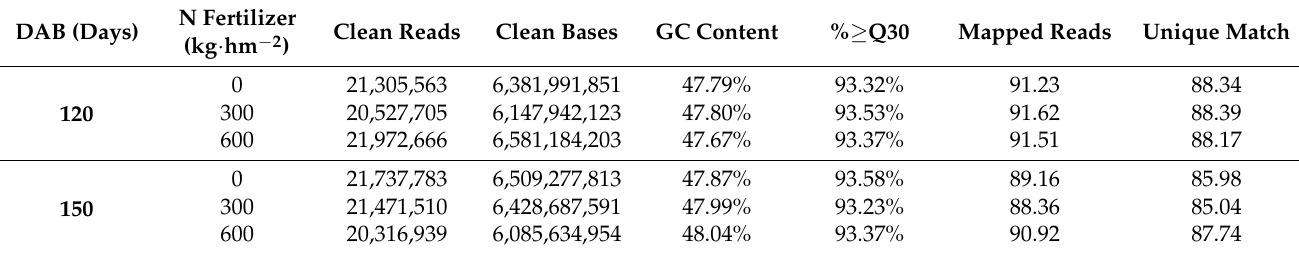
Table 1. The alignment statistics result with the reference gene for all